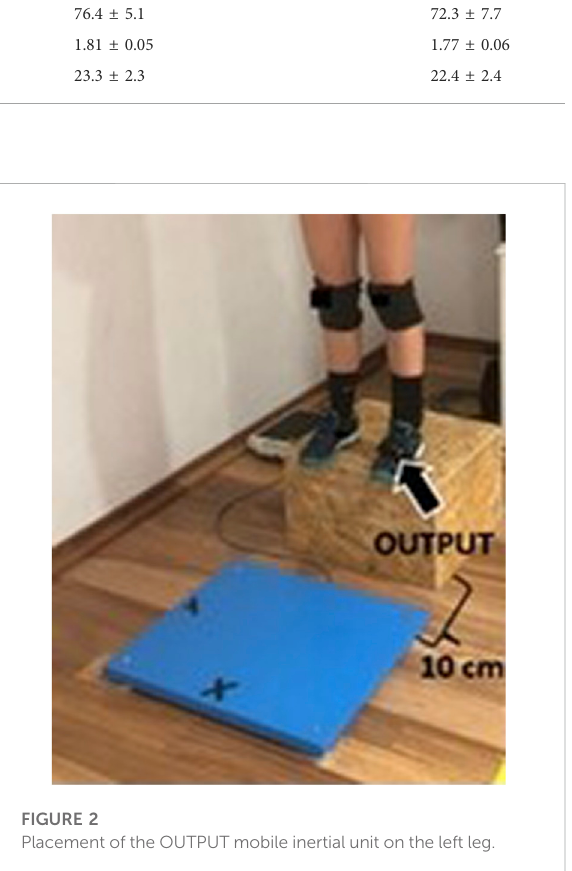
FIGURE 1 Separation of the mobile inertial unit OUTPUT at 10 cm from the force plate.